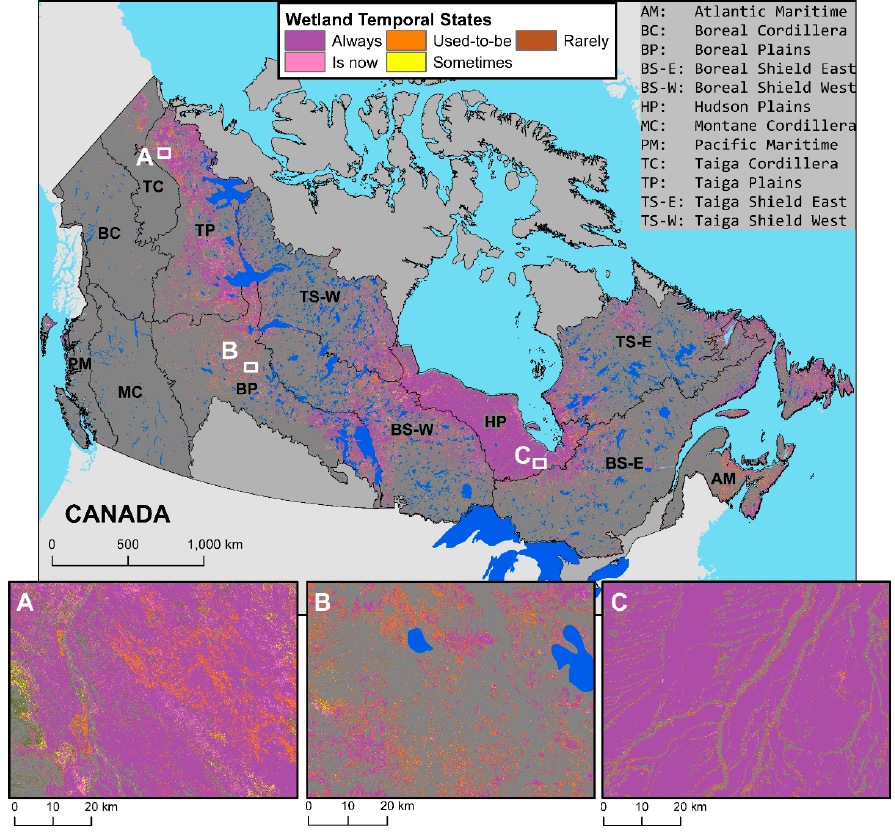
Figure 6. Wetland temporal states for the period, 1984–2016. Always (classified as wetland for ≥ 13 years both before and after 2000), Is Now (classified as wetland for <13 years before 2000 and for ≥ 13 years after 2000), Used-to-Be (was classified as wetland for ≥ 13 years before 2000 and for <13 years after 2000), Sometimes (an area not in the previous three categories, but that was classified as wetland for ≥ 13 years over the entire 33 years), and Rarely (an area that was classified as wetland for <13 years, but at least once over the entire 33 years). Grey represents non-wetland. Waterbodies are shown in blue for context.